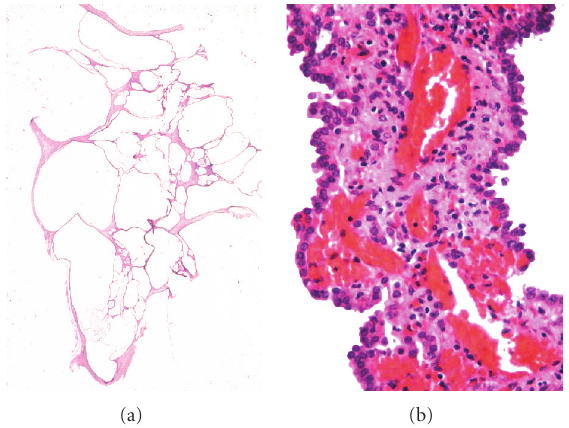
Figure 1: Cystic nephroma: cystic neoplasm with fibrous stroma an flat epithelium covering the wall.